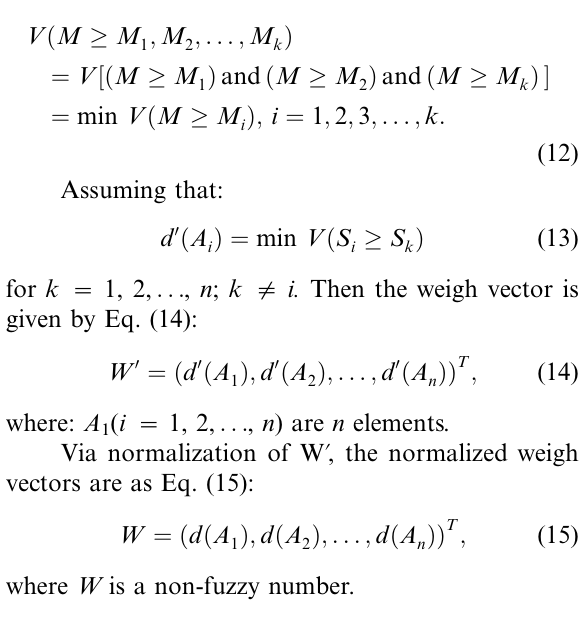
Table 6. Fuzzycomparison matrix with respect to ‘‘Weather’’ (Level